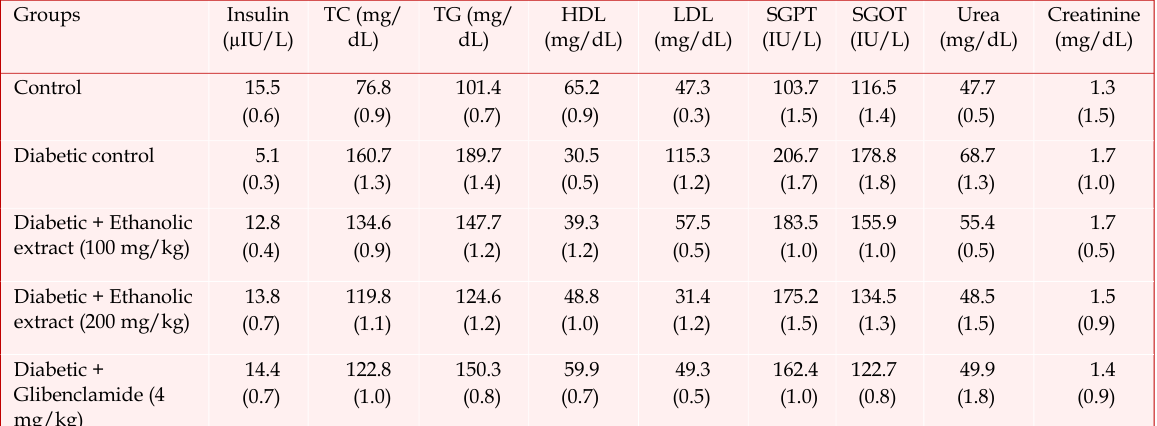
Effect of ethanolic extract of P. hababianum on serum profile in streptozotocin- induced diabetic rats for